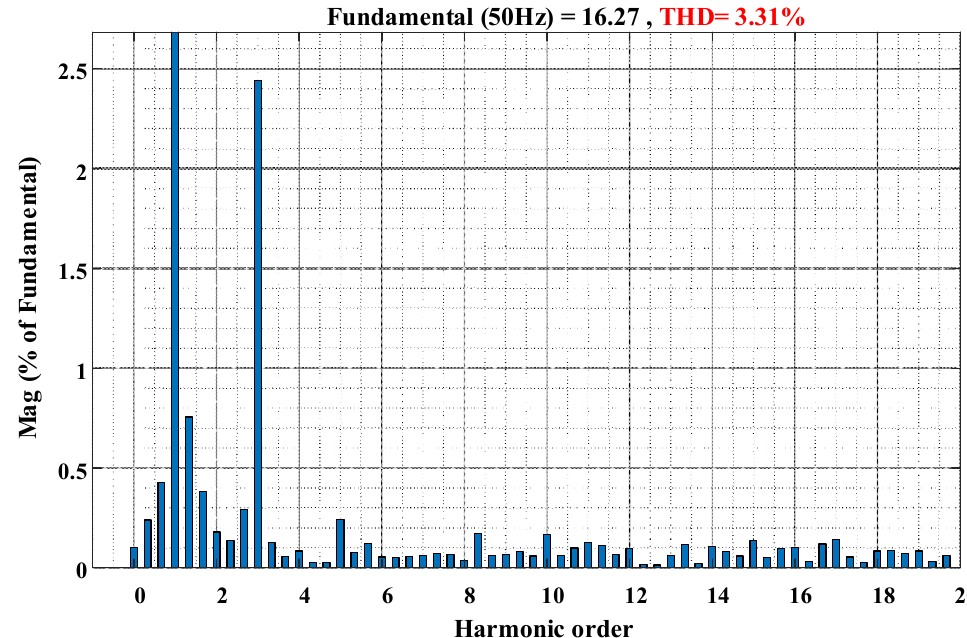
Figure 8. HVAC grid current THDi (20% of rated power).